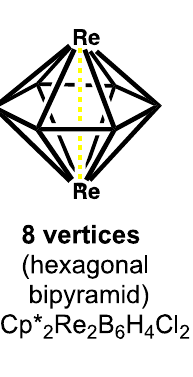
Figure 4. The oblate ellipsoidal ( oblatocloso ) deltahedra found in the dirhenaboranes Cp* 2 Re 2 B n − 2 H n − 2 (Cp* = η 5 -Me 5 C 5 ; 8 ≤ n ≤